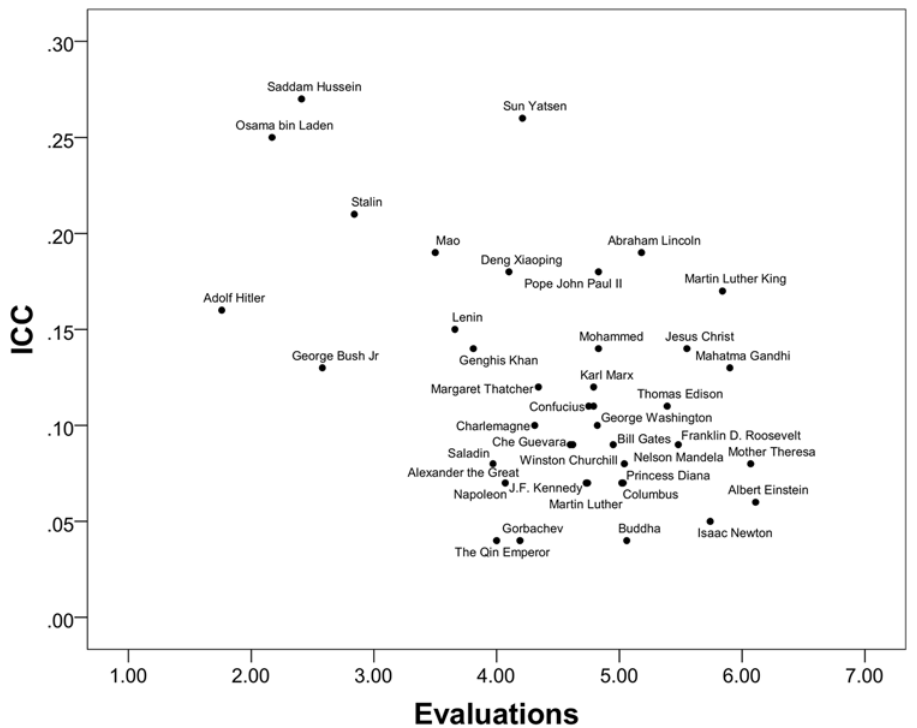
Fig 1. Intraclass correlation coefficients (ICC) and Evaluations